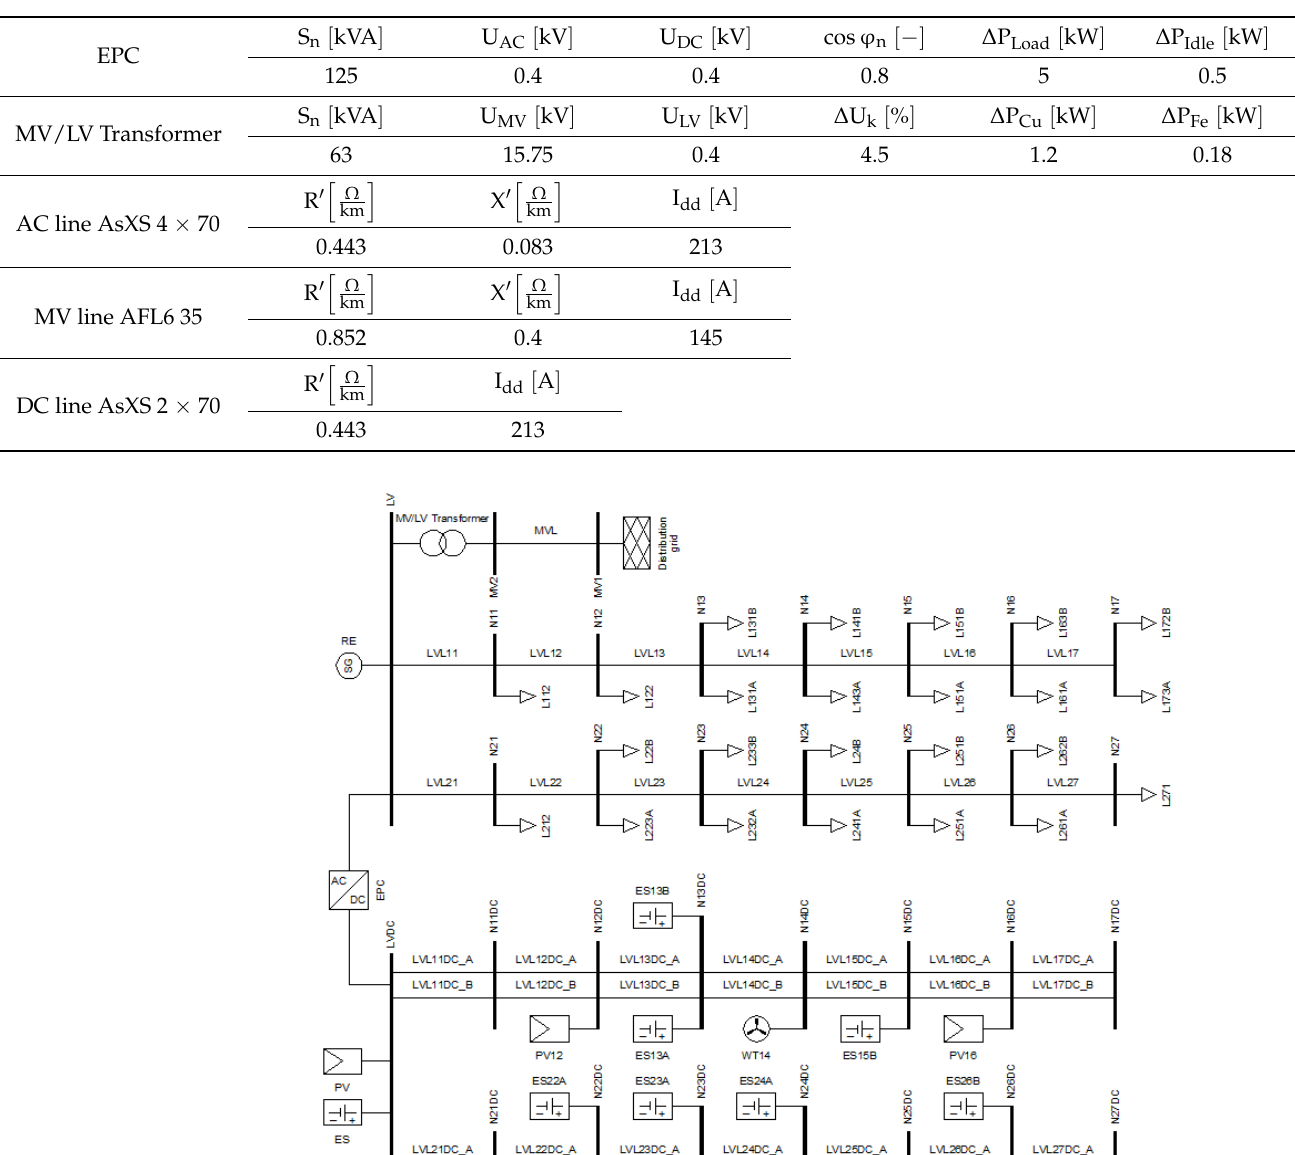
Table 1. Technical data of individual elements of the hybrid test microgrid.